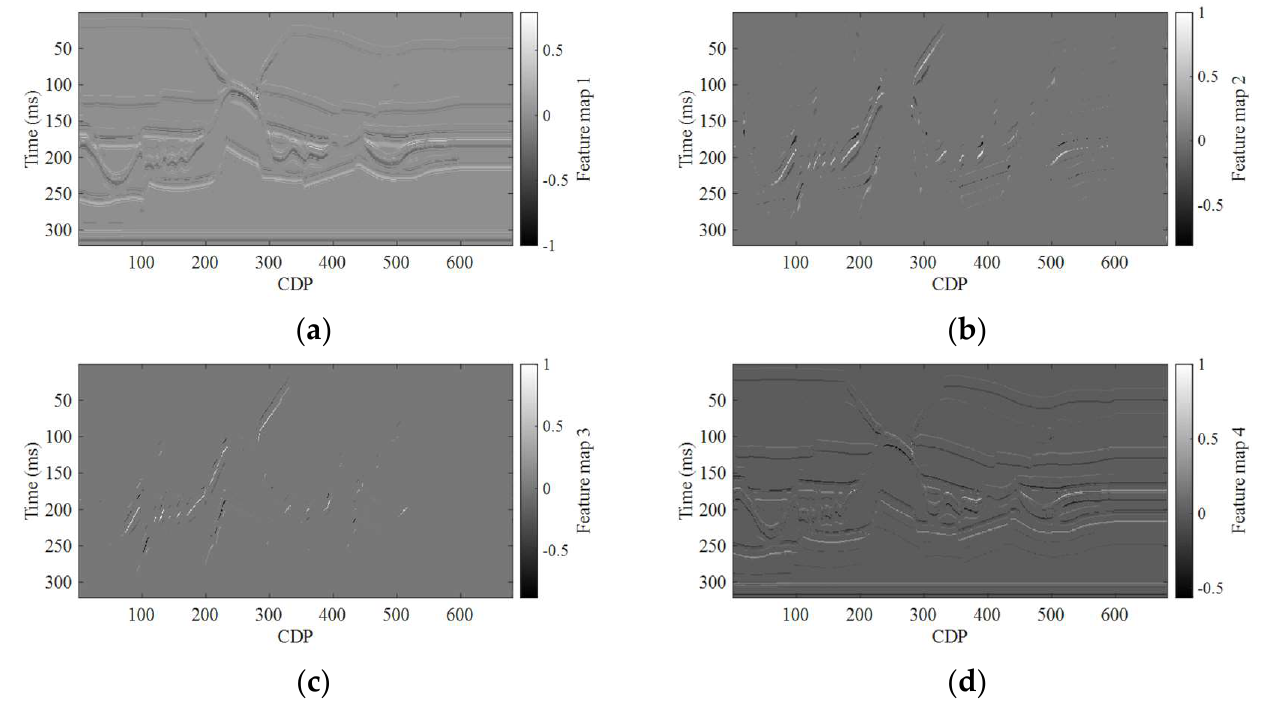
Figure 6. The feature maps from the ( a ) fifth, ( b ) tenth, ( c ) fifteenth, and ( d ) twentieth elements in sparse vector used for interpolation. Table 1. The computational time and REs for interpolations.